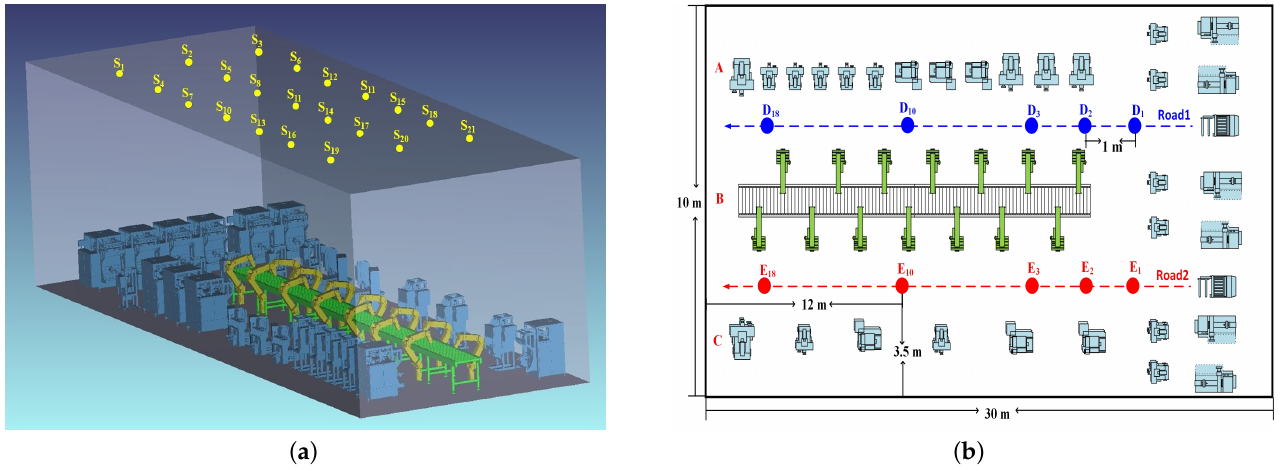
Figure 1. ( a ) The 3D IIoT simulation scenario; ( b ) The layout of the IIoT